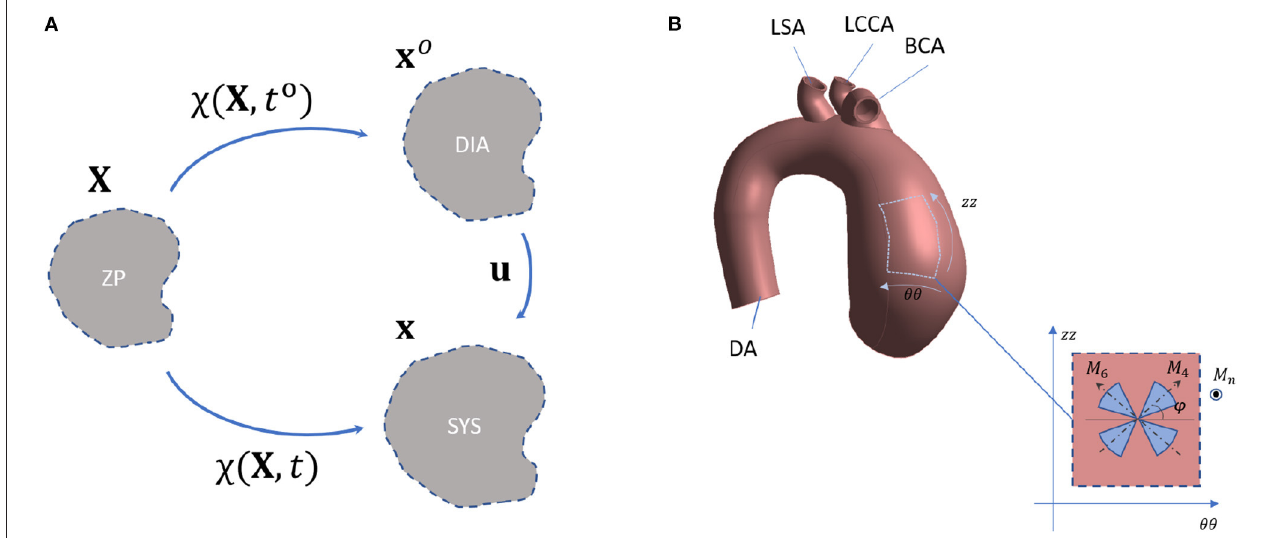
FIGURE 1 | (A) Schematic of the mechanical configurations according to SOL theory and (B) representation of the main directions of fibers in the aTAA specimen according to the fiber-based constitutive